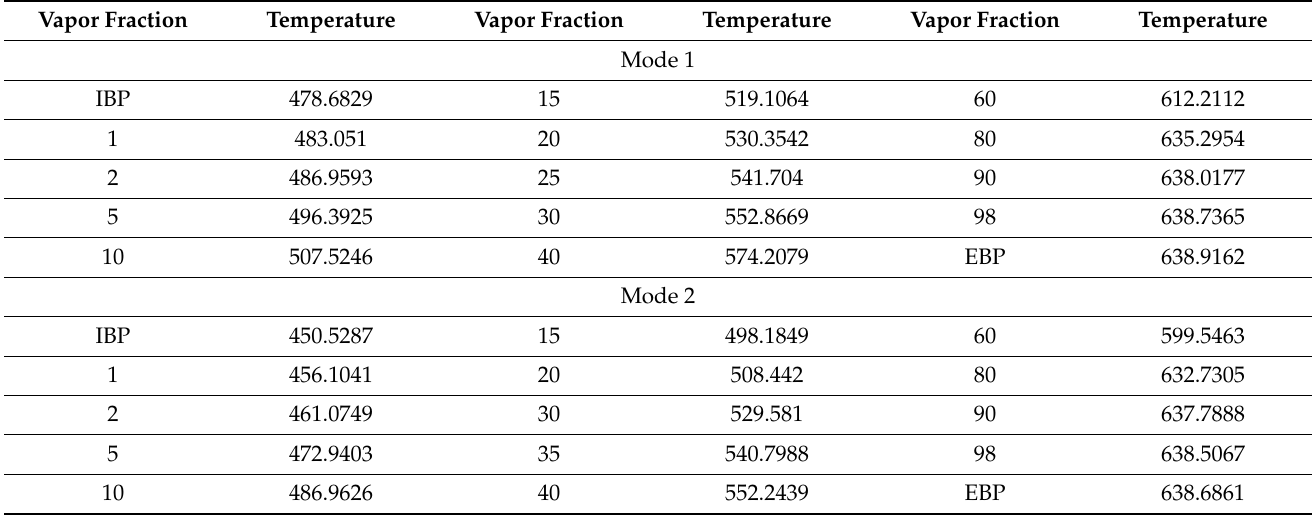
Table 16. Calculated values of the tar distillation